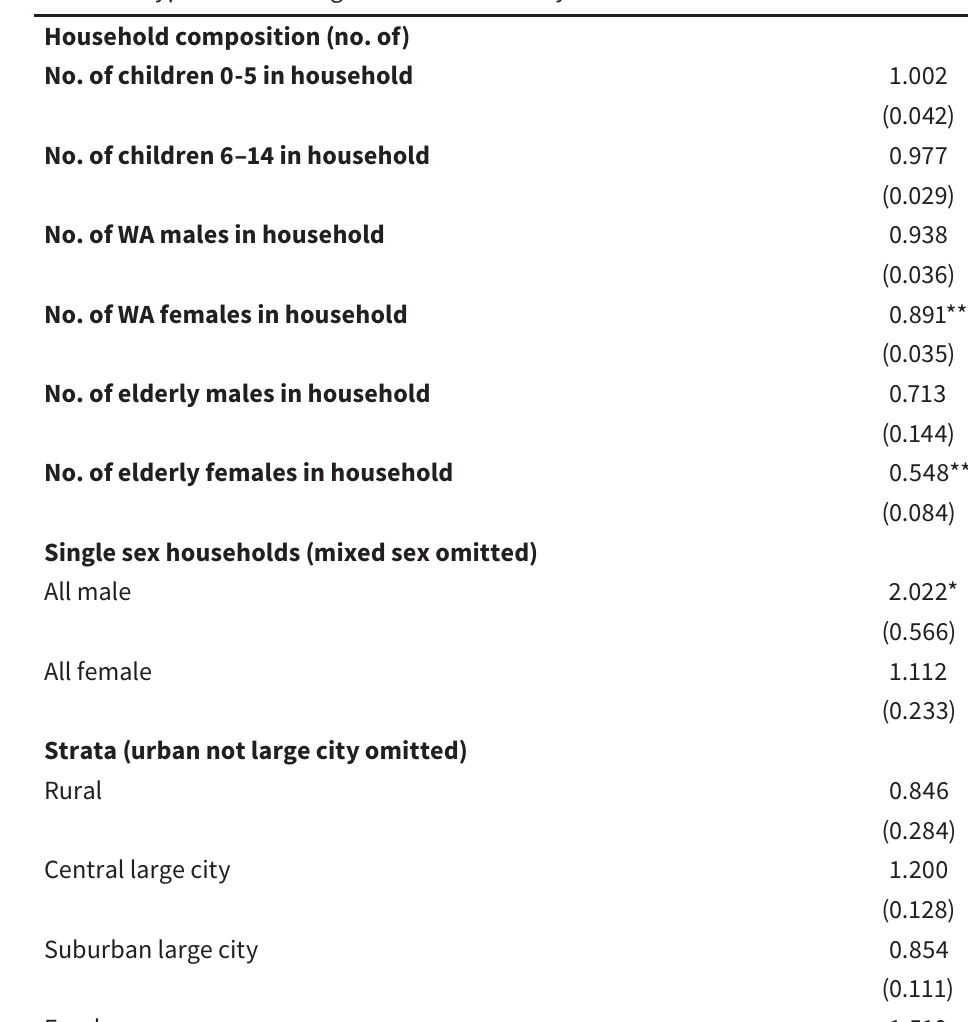
Type I attrition logit model: Probability household